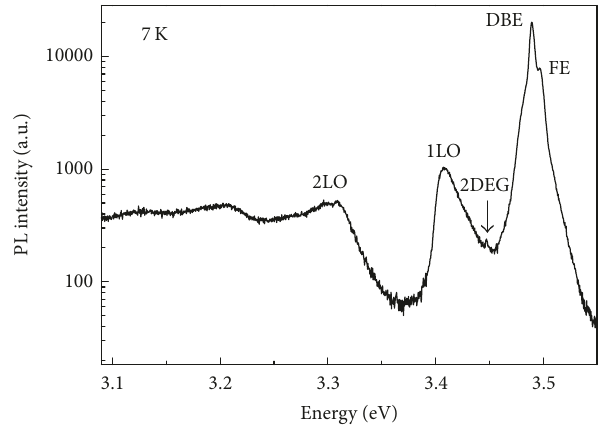
Figure 5: PL spectrum of AlGaN/GaN heterostructure at 7K.